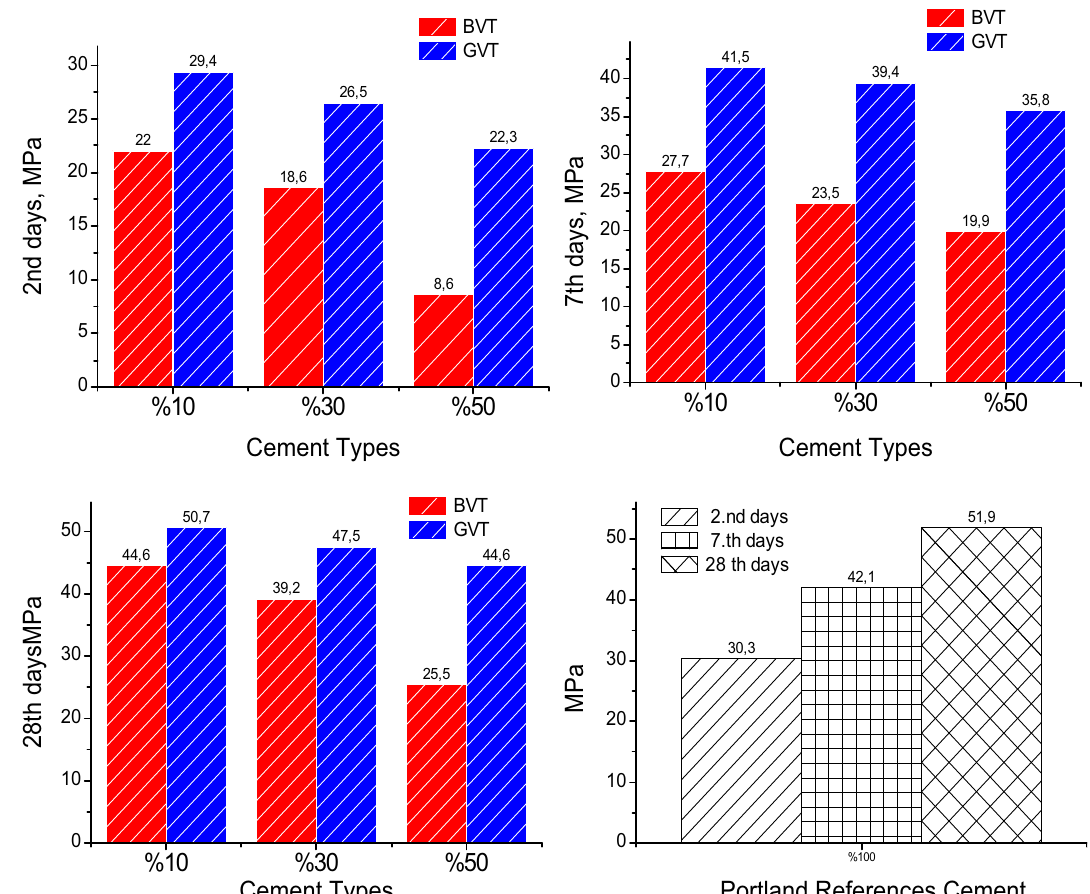
Figure 10: Compressive strength results of blended